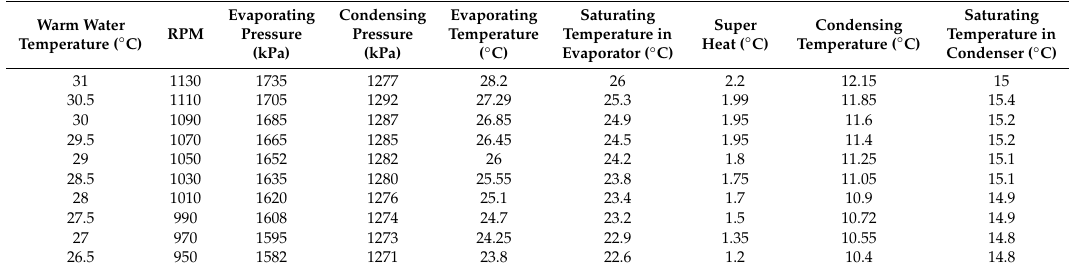
Table 4. Operating fluid pump RPM control range according to the surface water temperature (cold water temperature: 7.5 ◦ C).